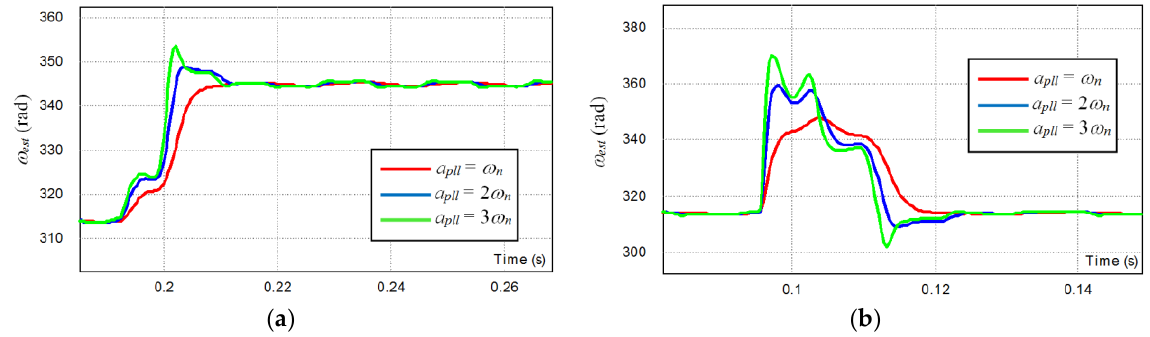
Figure 17. The estimated frequency for ( a ) input signal frequency step variation 31 rad/s, and for ( b ) input signal step phase angle variation 0.5 rad, for the FFPLL in Figure 8, for three different values of PLL parameters a pll and K s = 2, for nominal FFPLL frequency ω n = 314 rad/s and for input signal frequency ω e = 314 rad/s.